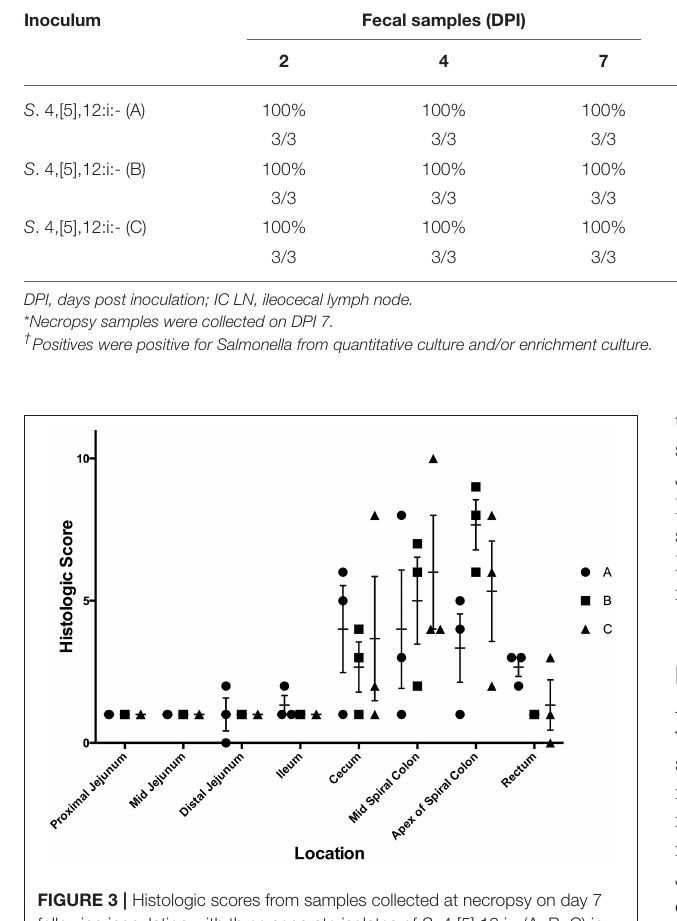
Culture positives †